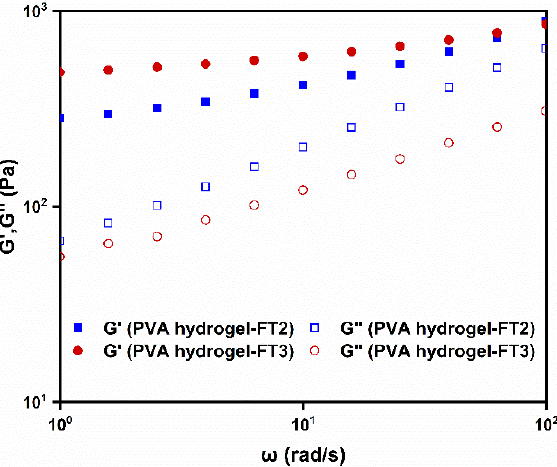
Figure 5. Rheological frequency sweep related to PVA hydrogels with being repetitively frozen and thawed two times (PVA hydrogel-FT2) and three times (PVA hydrogel-FT3).